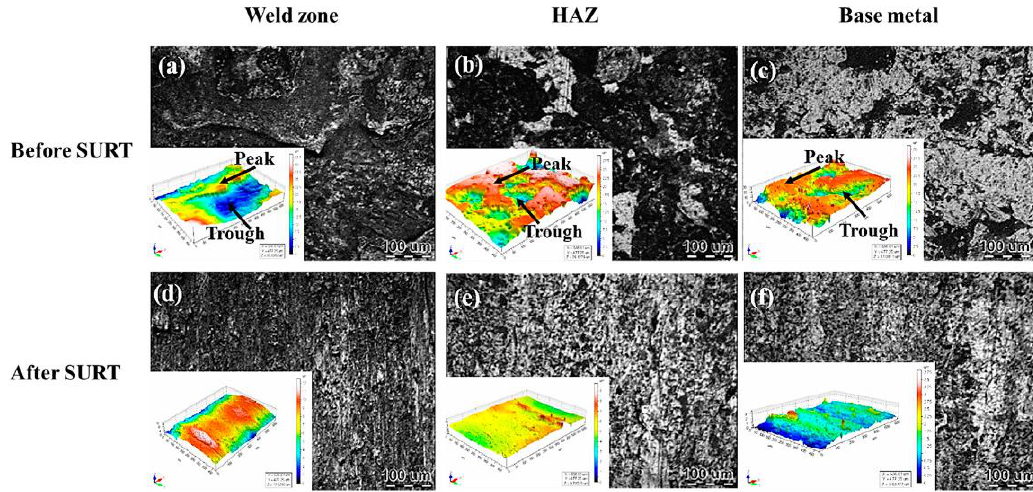
Figure 15. Surface morphology of T4003 ferritic SS welded joint before USRP on ( a ) weld zone, ( b ) HAZ, ( c ) base metal and after USRP on ( d ) weld zone, ( e ) HAZ, and ( f ) base metal. Reprinted with permission from ref. [48]. Copyright 2020 MDPI.